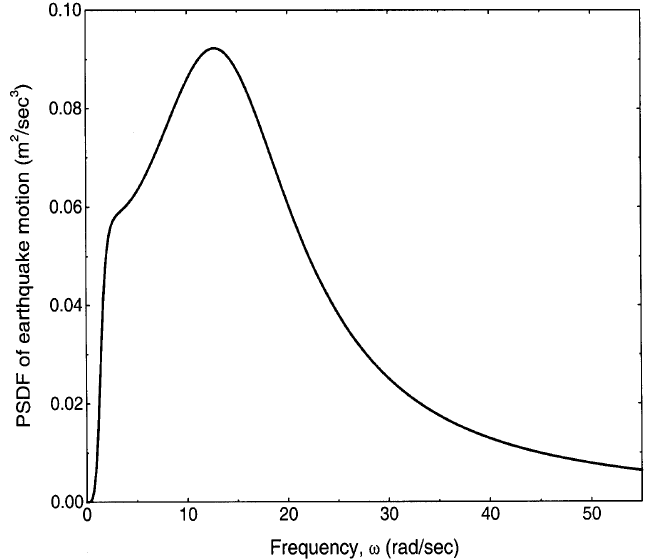
Fig. 3. Plot of PSDF of acceleration, ¨ u f ( t ) against the frequency ( ω g = 15 . 6 rad/sec, ω f = 1 . 5 rad/sec, ξ g = 0 . 6 , ξ f = 0 . 6 and S 0 = 0 . 05 m 2 / sec 3